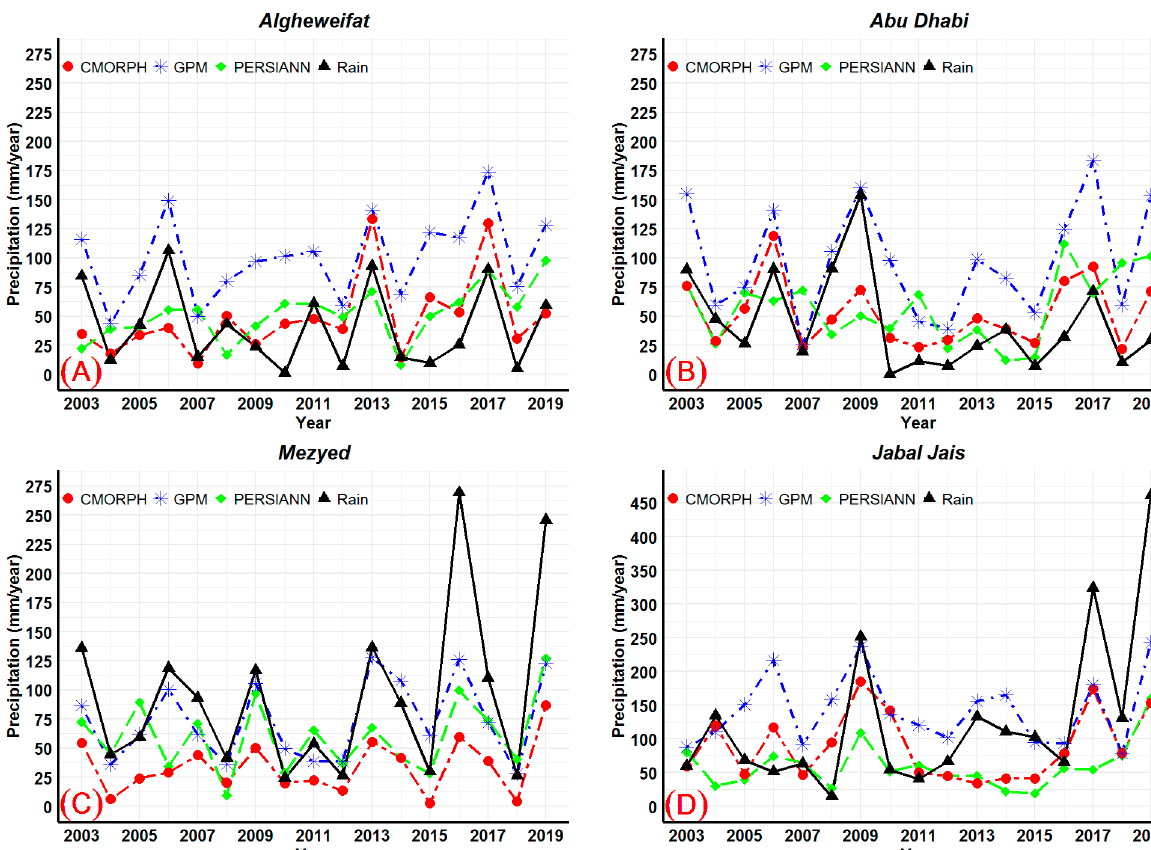
Figure 8. Time-series of annual satellite rainfall data at the location of ( A ) Al Gheweifat, ( B ) Abu Dhabi, ( C ) Mezyed, and ( D ) Jabal Jais rain gauge stations.